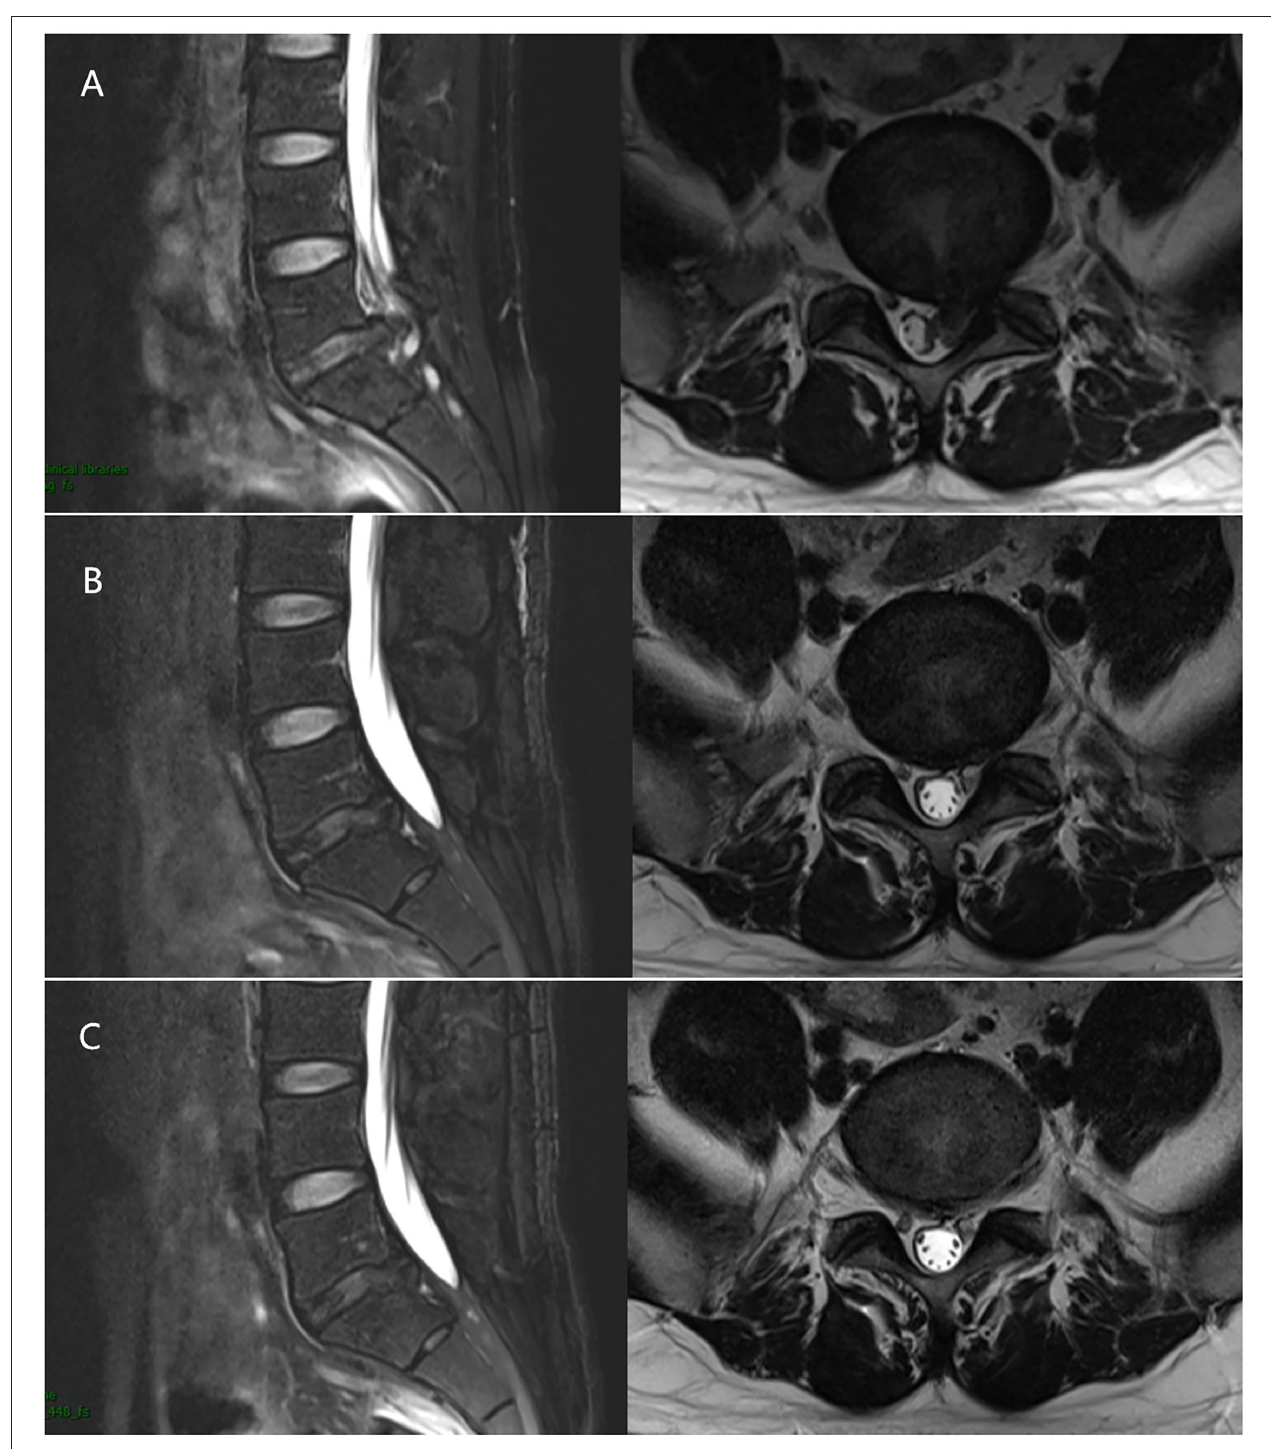
FIGURE 3 | A 33-year-old male with the L5/S1 LDH underwent PELD. (A) Preoperative MRI showed LDH was located at the L5/S1 level. (B) 1 month after surgery, MRI revealed the nerve root was decompressed without recurrence. (C) 3 months after surgery, MRI revealed the nerve root was decompressed without recurrence as